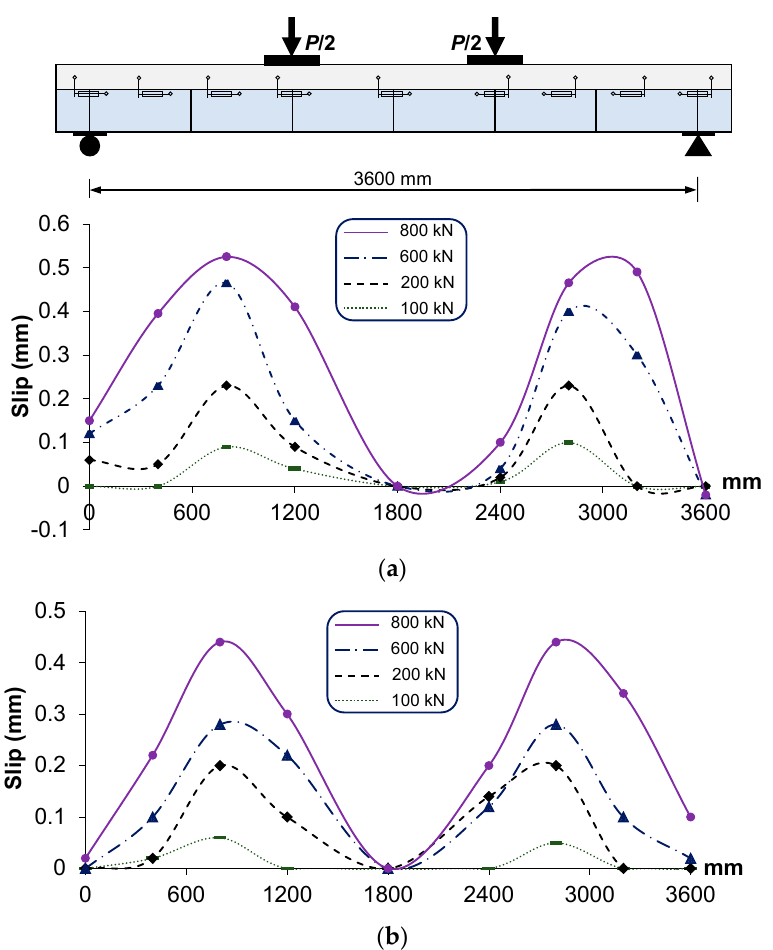
Figure 12. Interface slip at different loading stages: ( a ) results of Beam 1; ( b ) results of Beam 2.